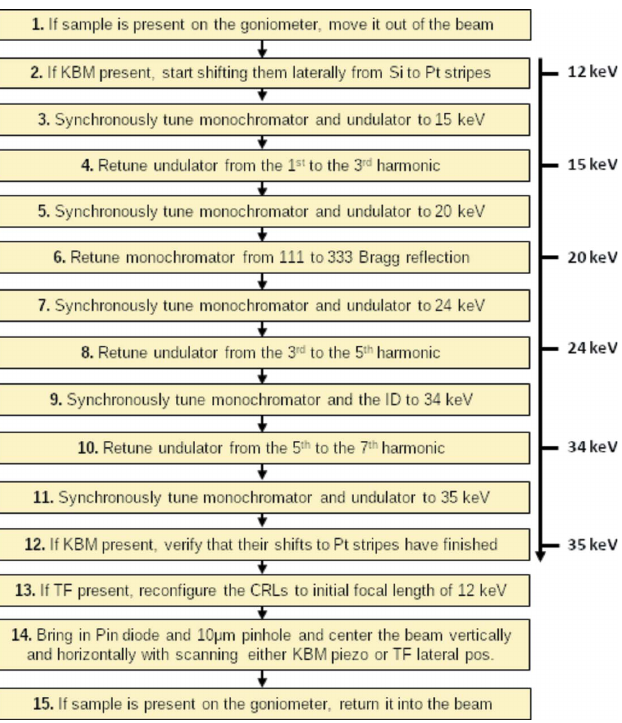
Figure 5 Diagram for retuning the beamline from 12 to 35 keV. At steps 3, 5, 7, 9, and 11, the intensity feedback maintains beam flux and the beam attenuation is preserved by changing the In/Out state of foils; at steps 4, 6, 8, and 10, the intensity feedback is